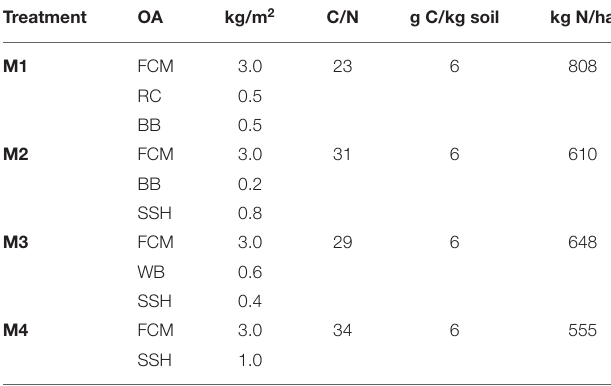
TABLE 2 | Doses in dry weight of the organic amendments used (FCM, fresh cow manure; RC, rapeseed cake; BB, beer bagasse; WB, wheat bran; SSH,